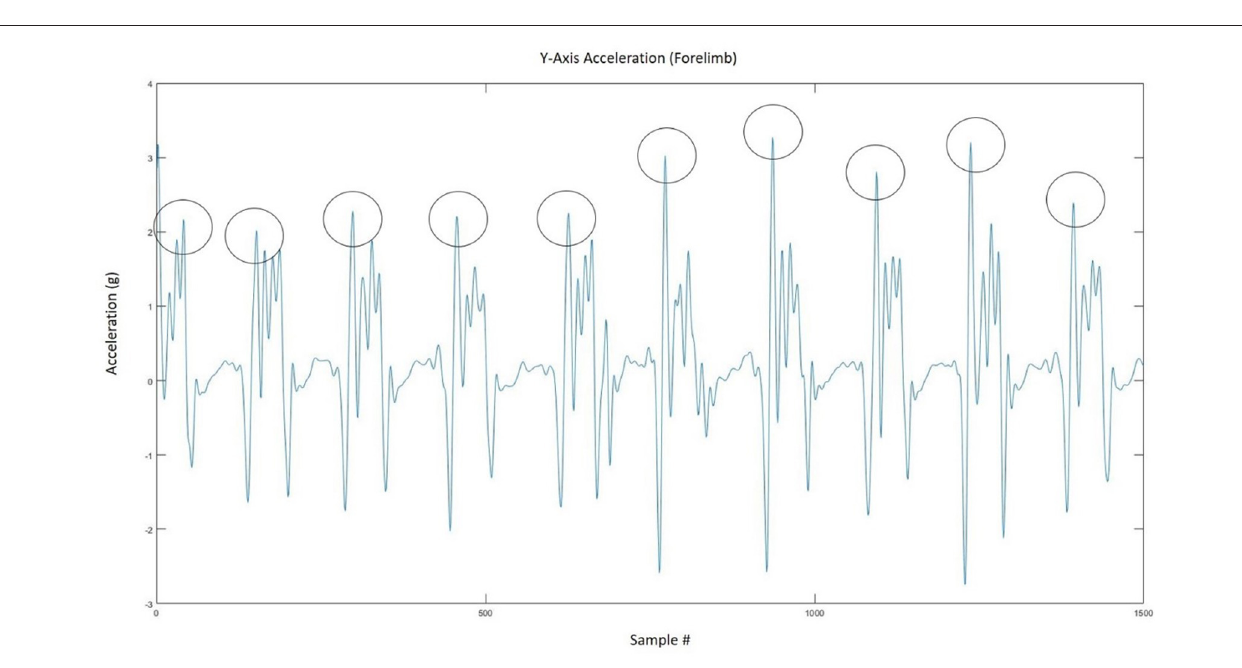
addition to the ICC analysis, the absolute step count difference (number of steps) and absolute percent error (%) between methods for each trial was also determined. The absolute value of the percent error was determined using the following